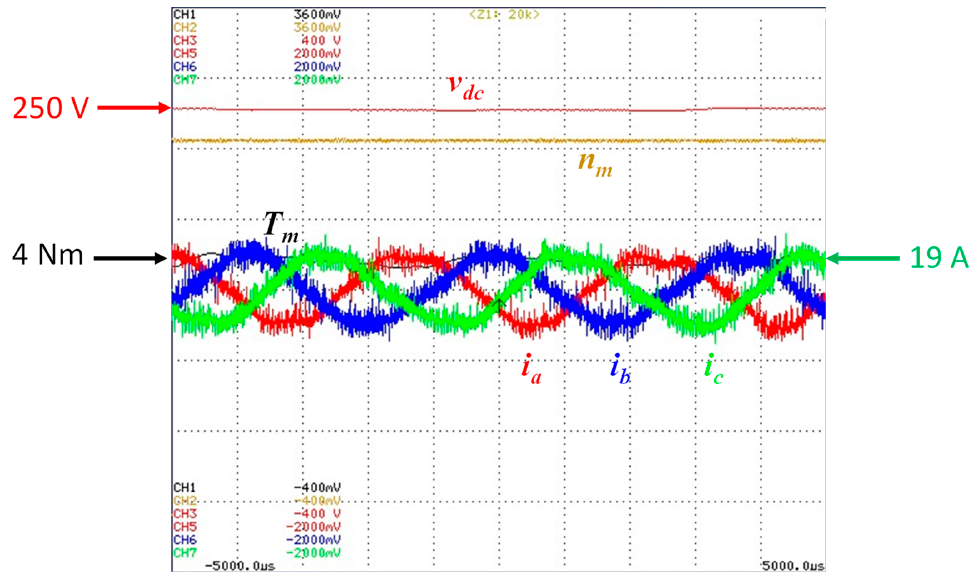
Figure 14. Experimental results of the traction system operating at a constant speed (4000 rpm) without a load: the torque ( T m ) and speed ( n m ) of the SRPM machine; dc-link voltage ( v dc ); stator windings’ currents ( i a , i b , i c ).